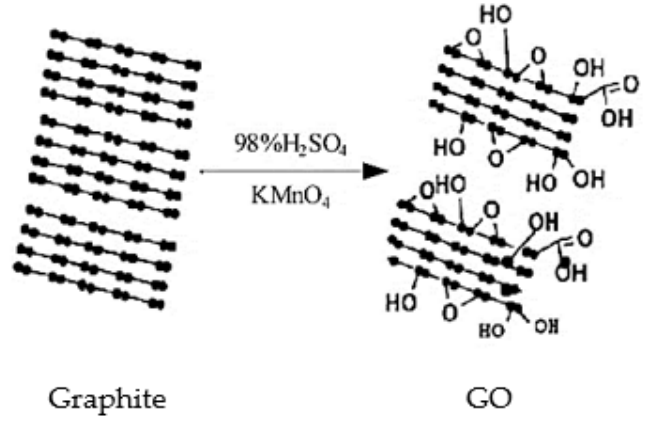
Figure 1. Diagram of GO preparation process.